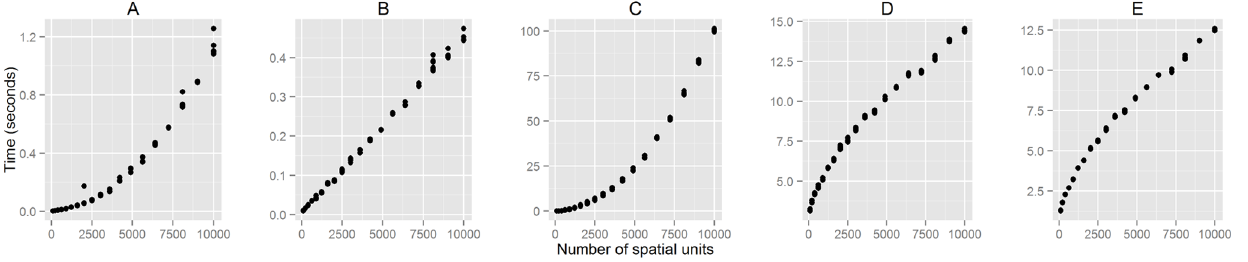
Figure 5. Computation time of the implemented functions for different input size. As the number of spatial units increases, the computation time also increases for all functions but at a different rate. The functions tested here are: dissim() (A), conprof() (B), isp() (C), spseg() (D), and deseg() (E).